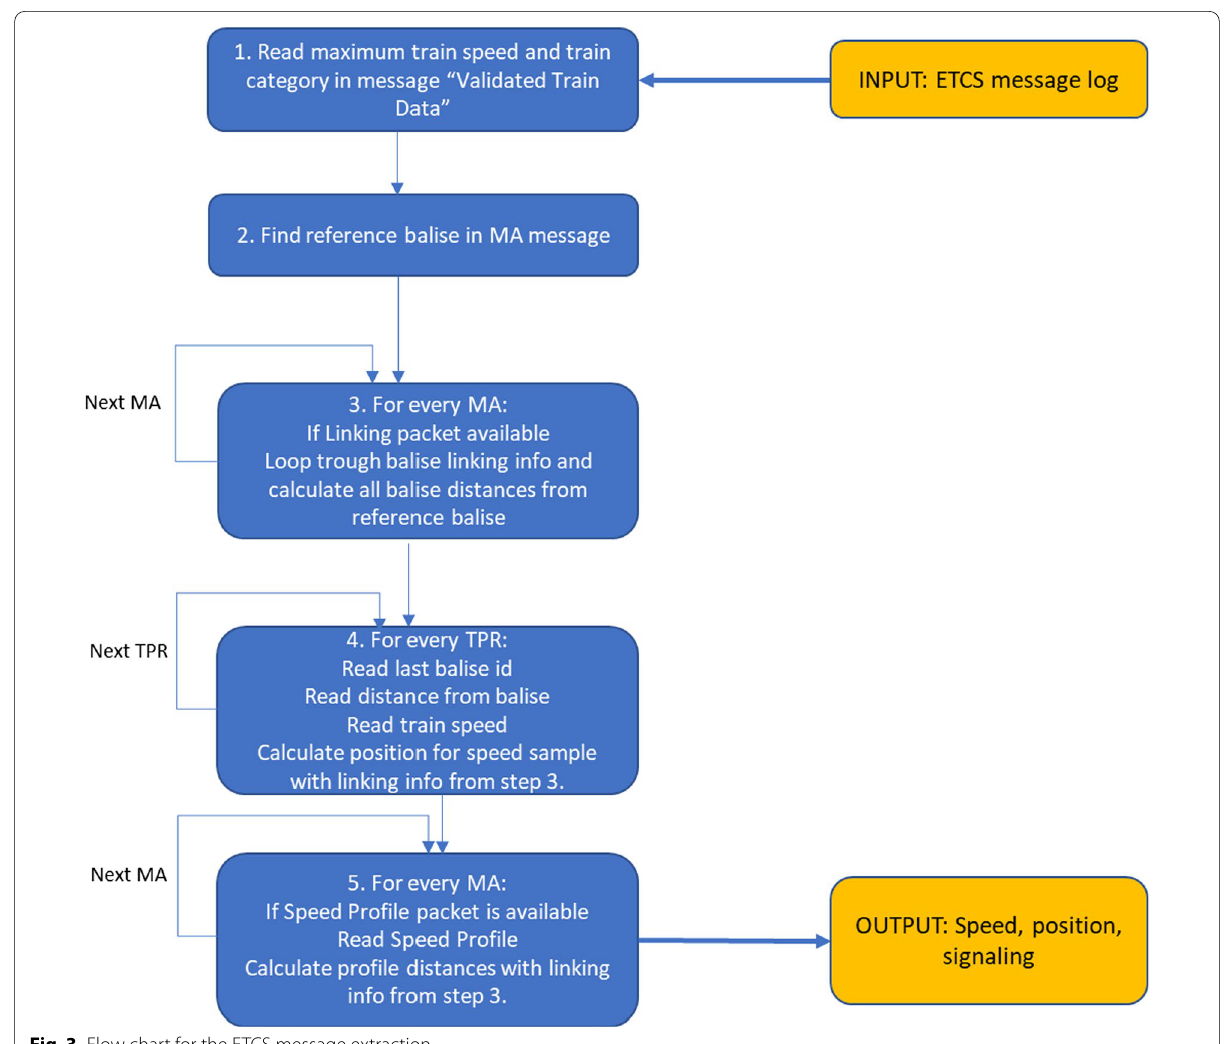
Fig. 3 Flow chart for the ETCS message